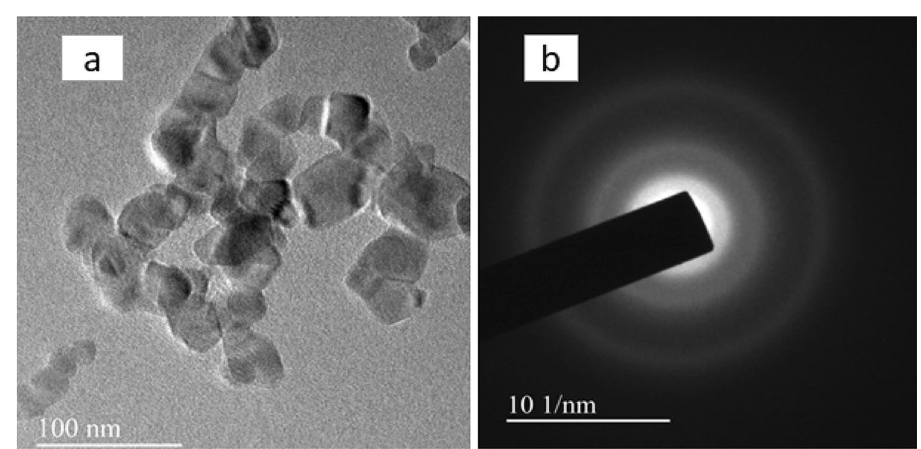
Figure 12. TEM image ( a ) and (b) SAED pattern of